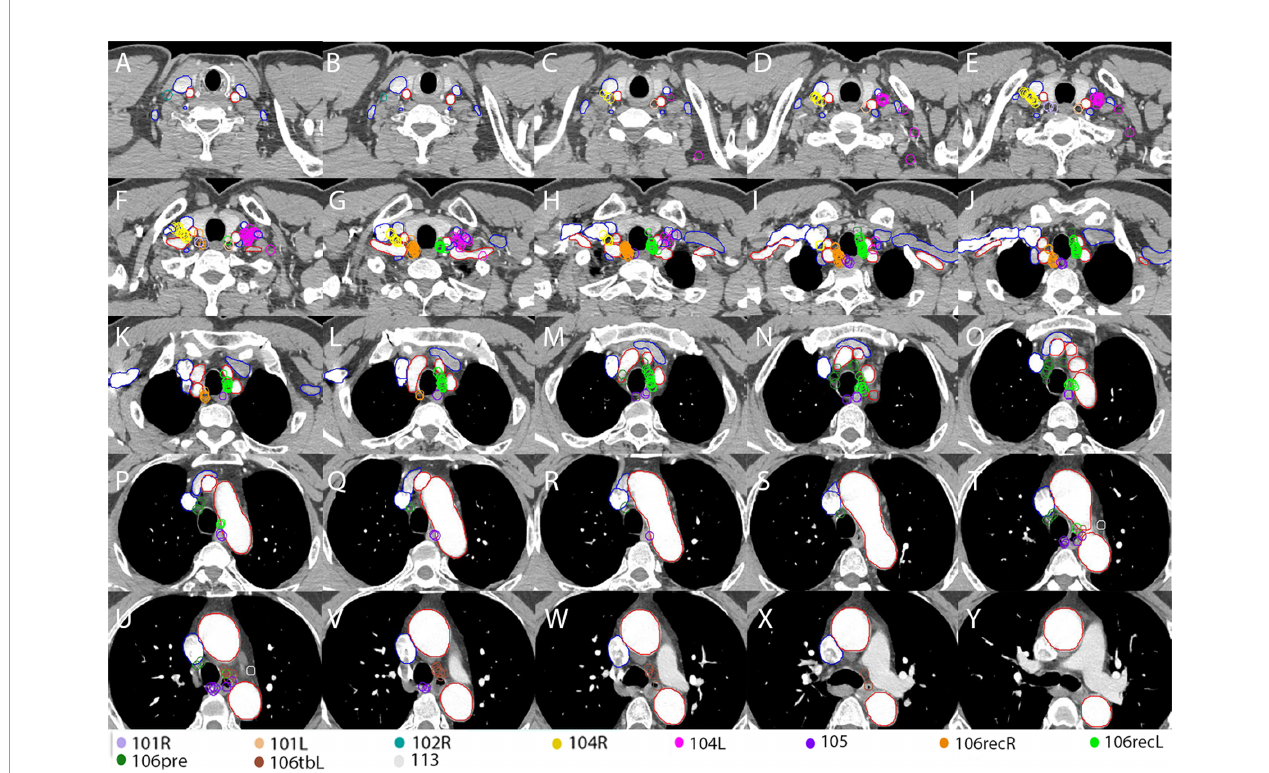
FIGURE 3 | Continuous cross-sectional images (a thickness of 5.00 mm) with all of the TVnds on the template CT (A – Y) . Red lines: arteries; Blue lines: